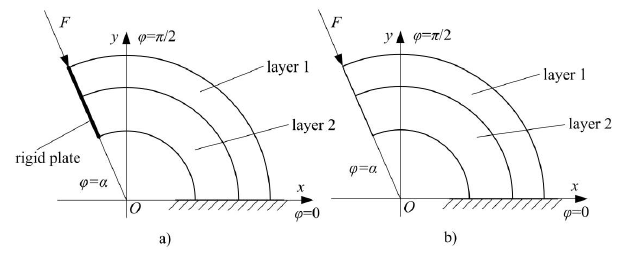
Figure 1: Applied radial load on the end cross